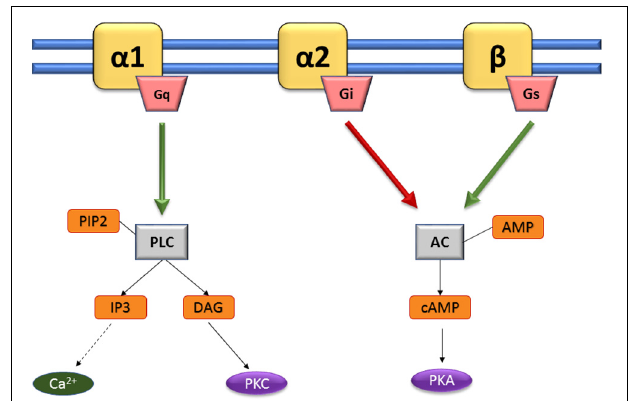
FIGURE 2 | Activating pathways of adrenergic sensors. Catecholamines activate various cellular signal transduction by binding to α 1-, α 2-, and β -adrenoreceptors (yellow). The α 1-receptor is coupled with Gq protein, allowing activation of kinase protein C (PKC) and increase of intracellular concentration of Ca2+, through the triphosphate inositol (IP3)/diacylglycerol (DAG) pathway. Activation of this pathway results from the cleavage of phosphatidylinositol-4,5-bisphosphate (PIP2) in IP3 and DAG thanks to phospholipase C (PLC). α -2 and β -receptors are coupled to Gi and Gs, respectively. In both cases, cAMP (cyclic adenosine monophosphate) is increased or decreased depending on the stimulation (Gs) or inhibition (Gi) of adenylate cyclase (AC), leading to the activation of kinase protein A (PKA). Adapted from Andreis and Singer